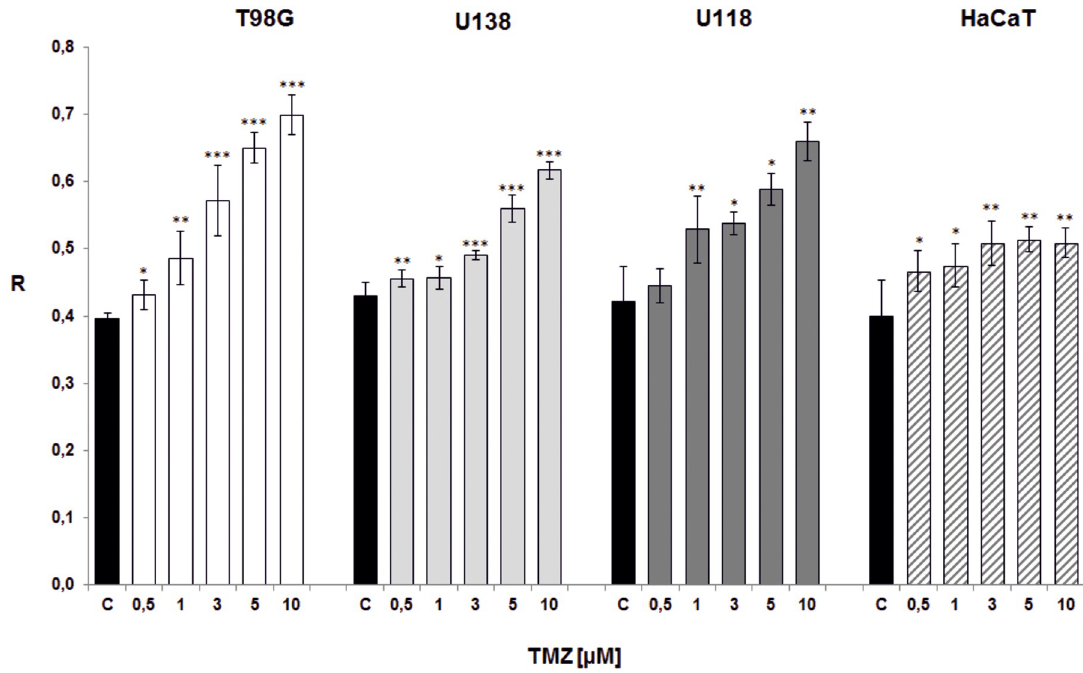
Fig 7. The effect of repetitive doses of TMZ on total DNA methylation. Total amount of m 5 C in DNA (R) changes during Stupp- mimicking TMZ-therapy. TMZ was administered to glioblastoma (T98G –white bars, U138 –light grey bars, U118 –dark grey bars) and keratinocyte (HaCaT–diagonally striped bars) cell lines at 0.5, 1, 3, 5, 10 μ M concentrations for 5 days. Each day cells were washed with PBS and placed in fresh medium with indicated TMZ concentrations. Control (C) cells were treated with DMSO only. The total DNA methylation was estimated after 5 th day of treatment. The R values are means from three experiments ± SD. Asterisks indicate a significant difference ( � p < 0,05, �� p < 0,01, ��� p < 0,001) from the control (DMSO) value.